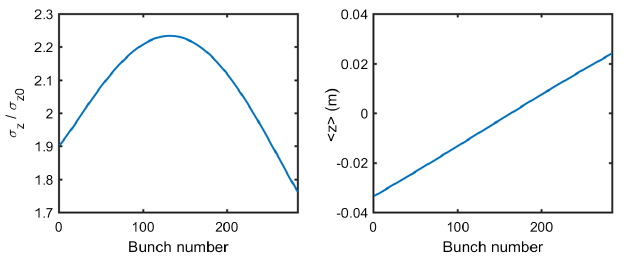
FIG. 6. Results for a single gap of 44 empty buckets. In the left plot, the ratio of rms bunch length to the natural bunch length vs bunch number, head of the train on the right. In the right plot, the corresponding graph of the centroid position.